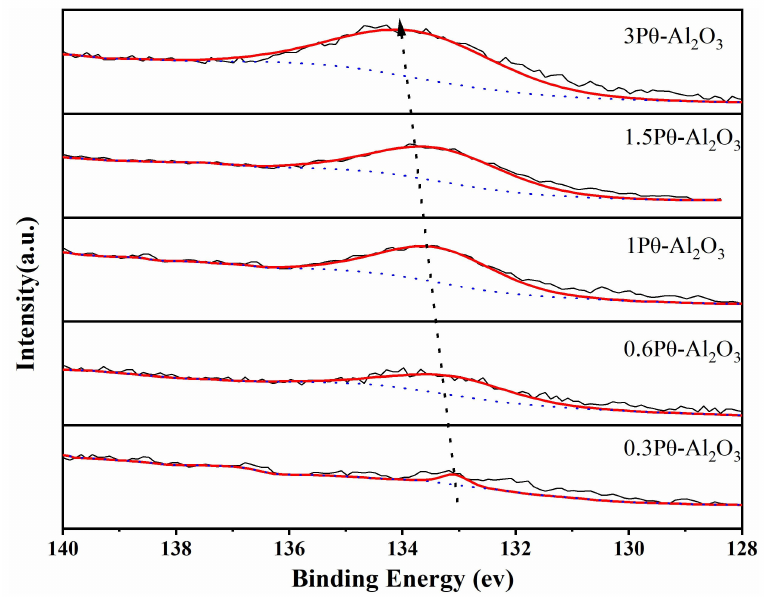
Figure 4. XPS spectra of P 2p for supports.